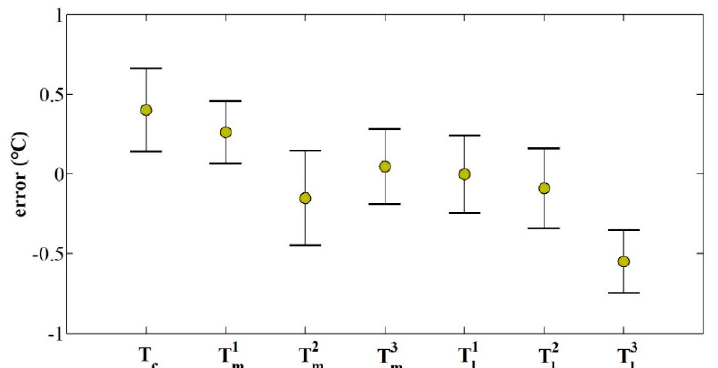
Figure 6. Errors between measured and calculated temperatures: the marker represents the average error, which ranges from − 0.6 to 0.5 °C; the error bar represents the variance of the error, which ranges from 0.2 to 0.3 °C.